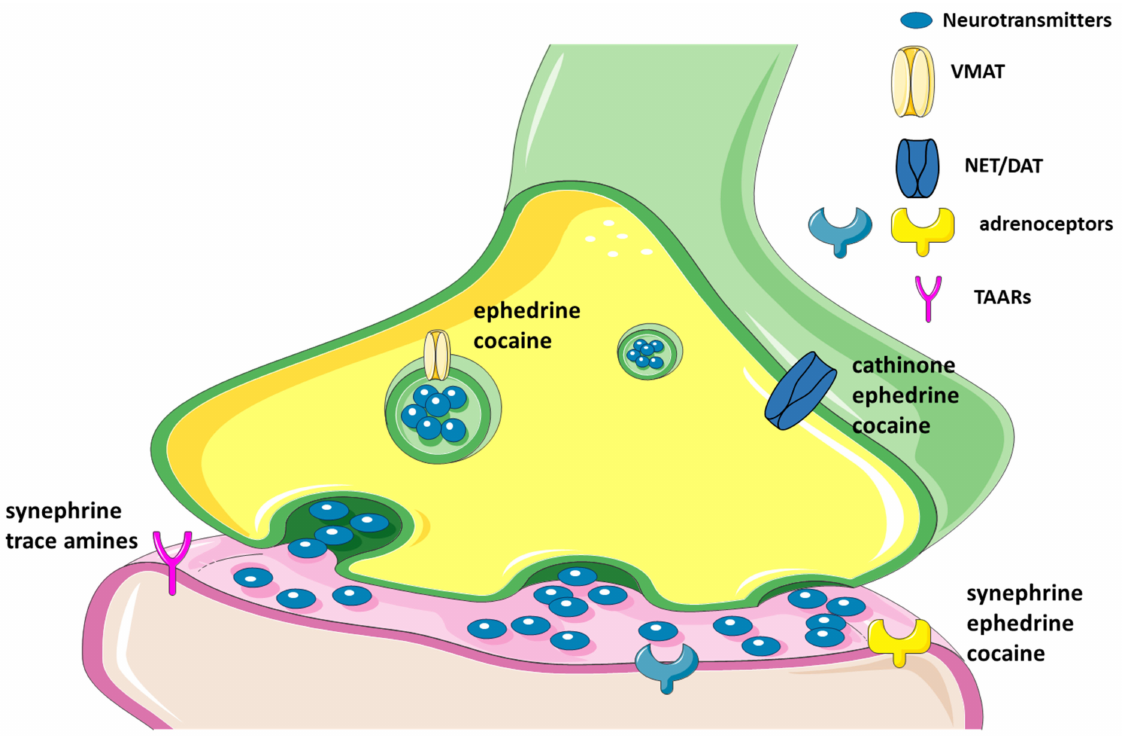
Figure 4. Interactions on the synaptic cleft of several sympathomimetics. Figure built resourcing to the blocks of Servier Medical